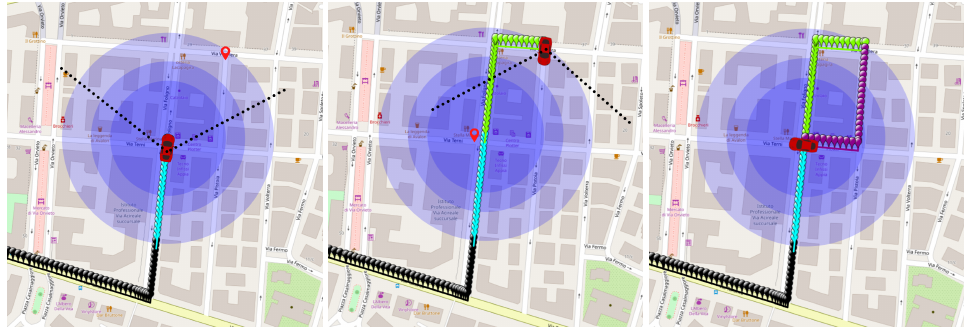
Figure 2. Example of a moving